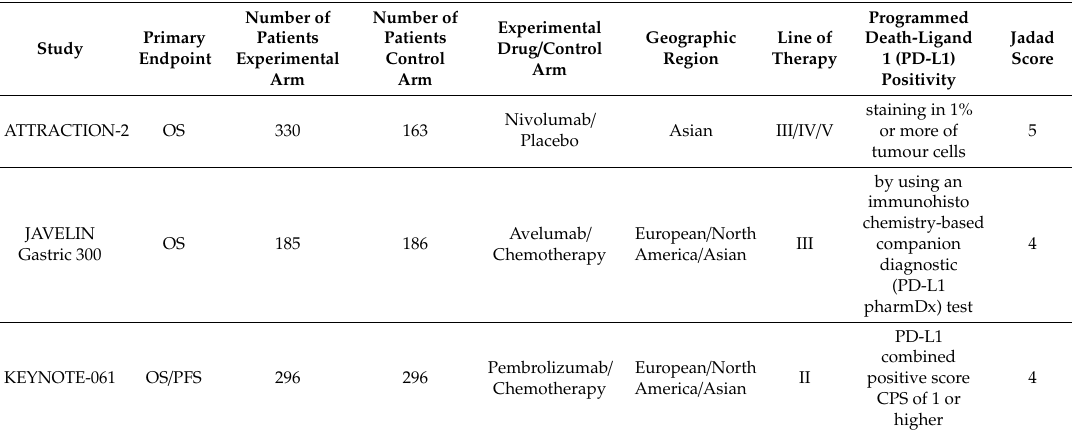
Table 1. Characteristics of the analysed